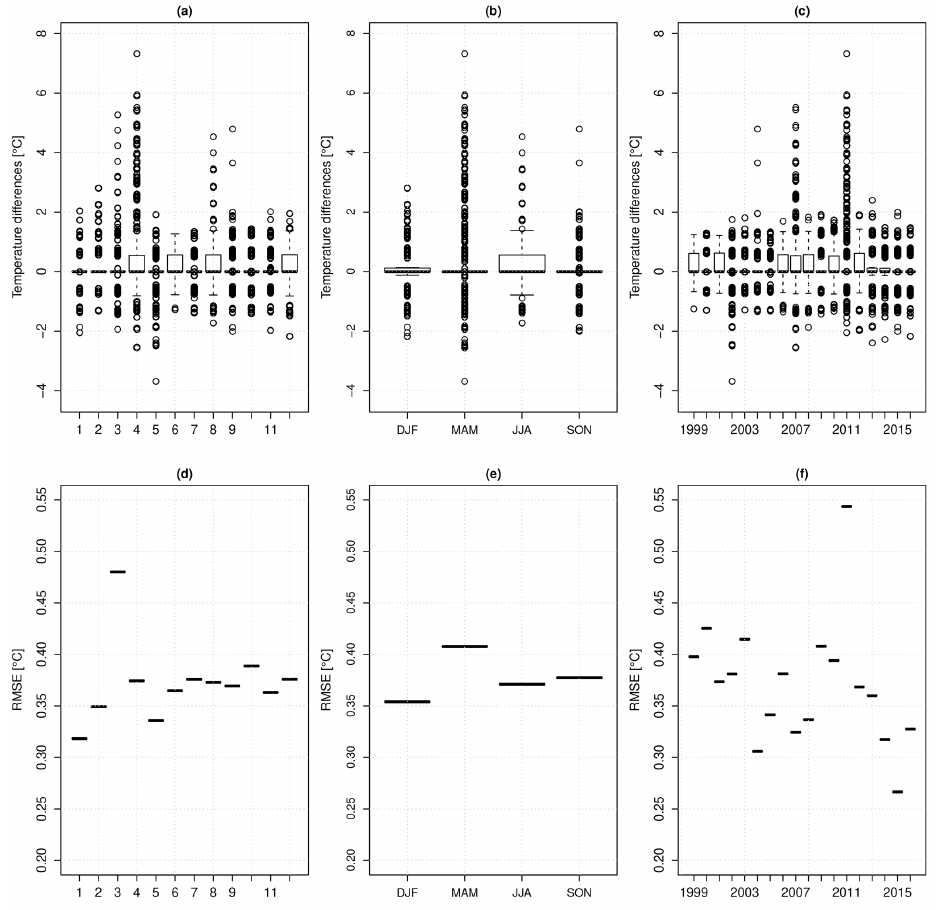
Figure 9. Above: box plots of the differences in temperature between consecutive scenes for individual pixels grouped by month of the year (a) , by season (b) and by year (c) . Below: Root mean square error of the temperature differences grouped by month of the year (d) , by season (e) and by year (f)